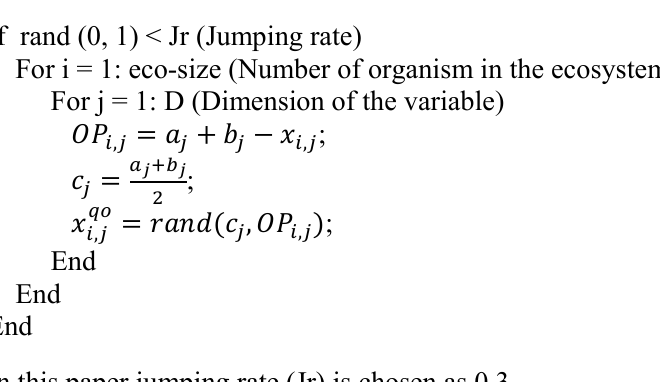
Fig. 1. Flowchart of the proposed QOSOS